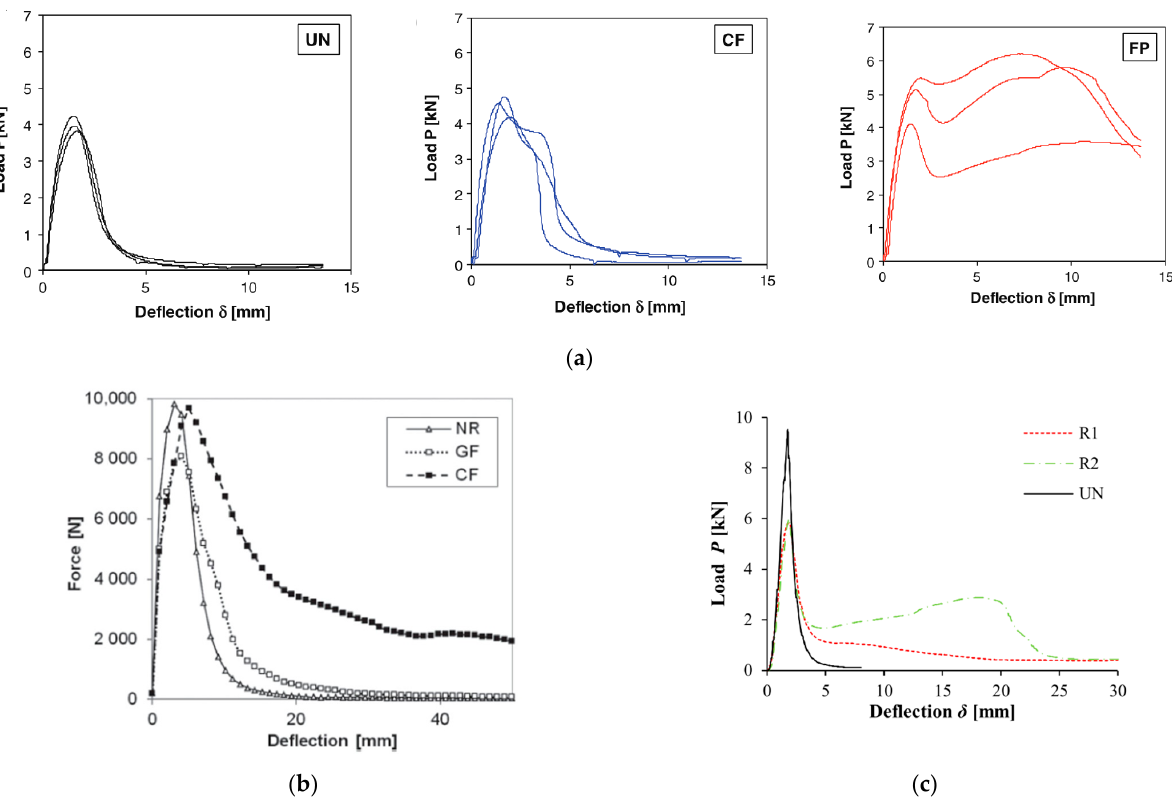
Figure 4. The load–deflection curves obtained by other scholars. ( a ) Reprinted with permission from [7]; Copyright 2013 Springer Nature; ( b ) Reprinted with permission from [8]; Copyright 2018 Taylor & Francis; ( c ) Reprinted with permission from [9].